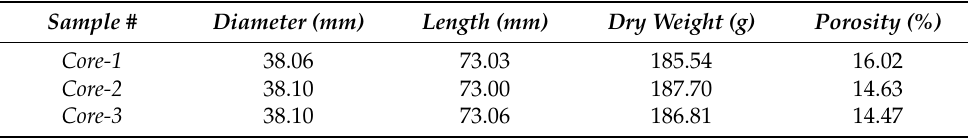
Table 1. Physical properties of the core samples used in the study.